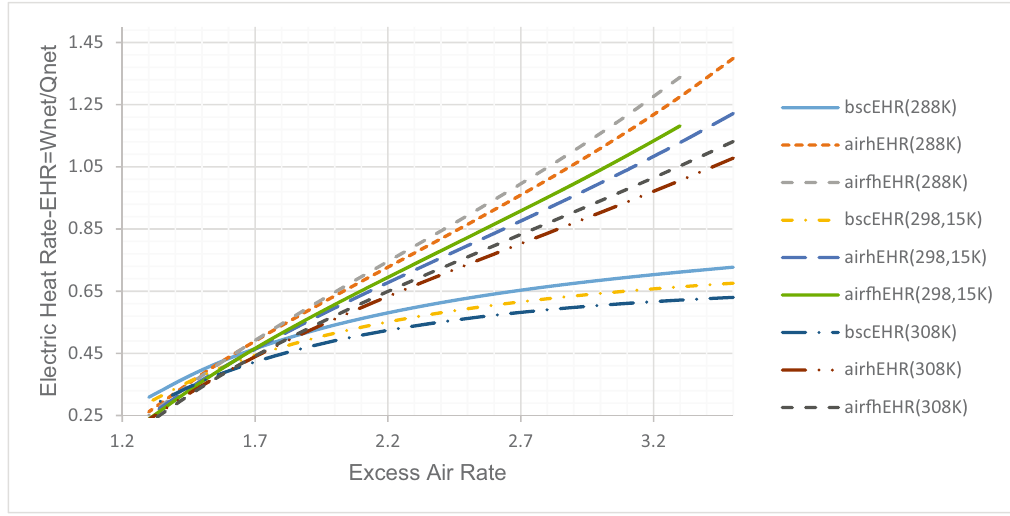
Figure 6: Variation of electrical heat energy ratio with air excess coe ffi cient at di ff erent compressor inlet temperatures for basic ( bsc ) , absorption cooling ( ab ) , air ( airh ) , and air fuel ( airfh ) heating cogeneration cycles ( m fuel = 1.64 kg/s, η isC = η isT = 0.86, r = 10, T recout = 850 K, T = 485.57 K, and T = 426 K ) . steam Exh